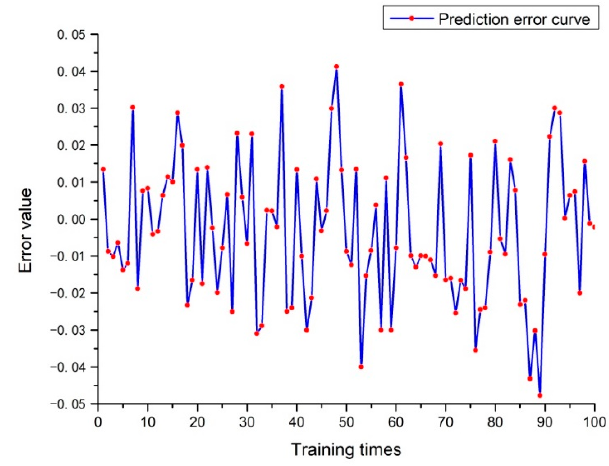
Figure 12. Overall error of training samples in GA_BP neural network.